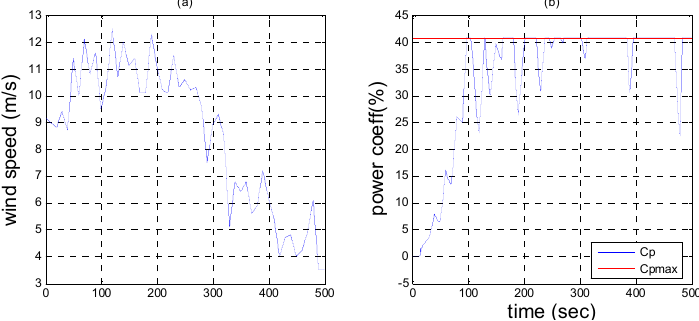
Figure 20. Generator performance in Region 2: ( a ) Generator speed; ( b ) Output power; ( c ) Electromagnetic torque.